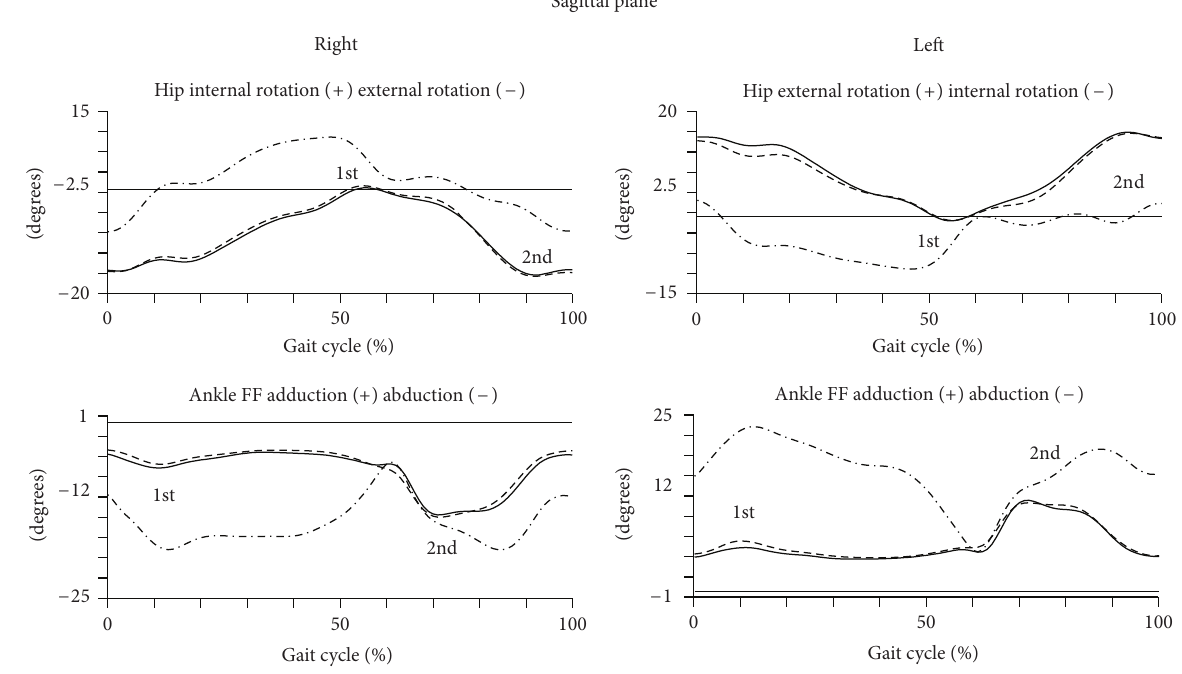
Figure 4: Kinematic parameters (transverse plane) of gait of pregnant women in the later stages of second trimester (dashed line) and third trimester (solid line) and of nulliparous controls (dot line). Mean joint angles of the hip and ankle, for right and left lower limbs, in degrees. The curve peaks are indicated by numbers: first and second and ( ∗ ) points the significant